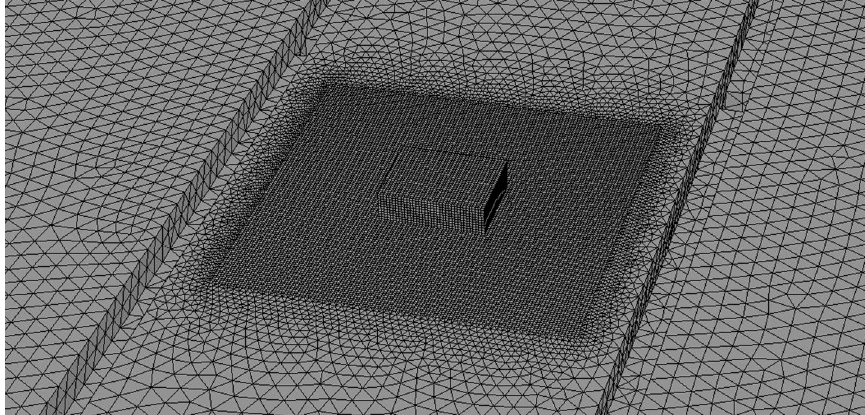
Figure 2. A sample view of the numerical mesh used in the analysis—structured Cartesian mesh ( δ x = 0.1 m) in the vicinity of ventilator and area above the fire and unstructured tetrahedral mesh (max. δ i = 0.4 m) in the rest of the domain.